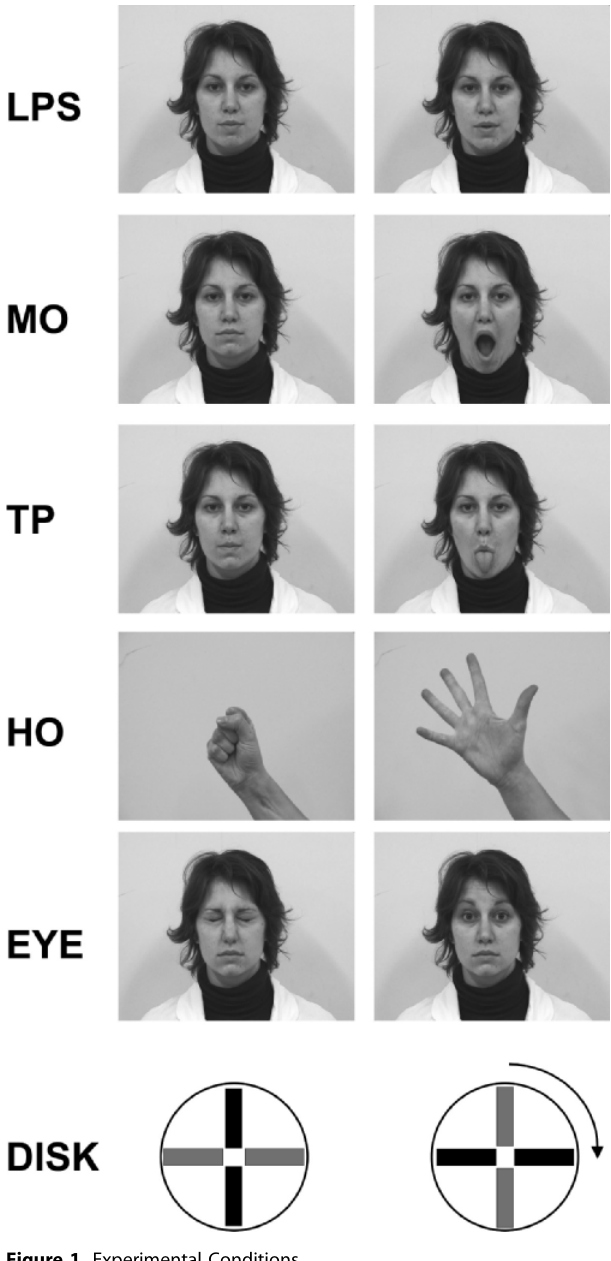
Figure 1. Experimental Conditions Figures on the left represent stimuli during resting conditions and baseline. Figures on the right depict the stimuli when fully expressed. In the DISK condition, the disk was repeatedly rotated 90 8 clockwise and counterclockwise. DOI: